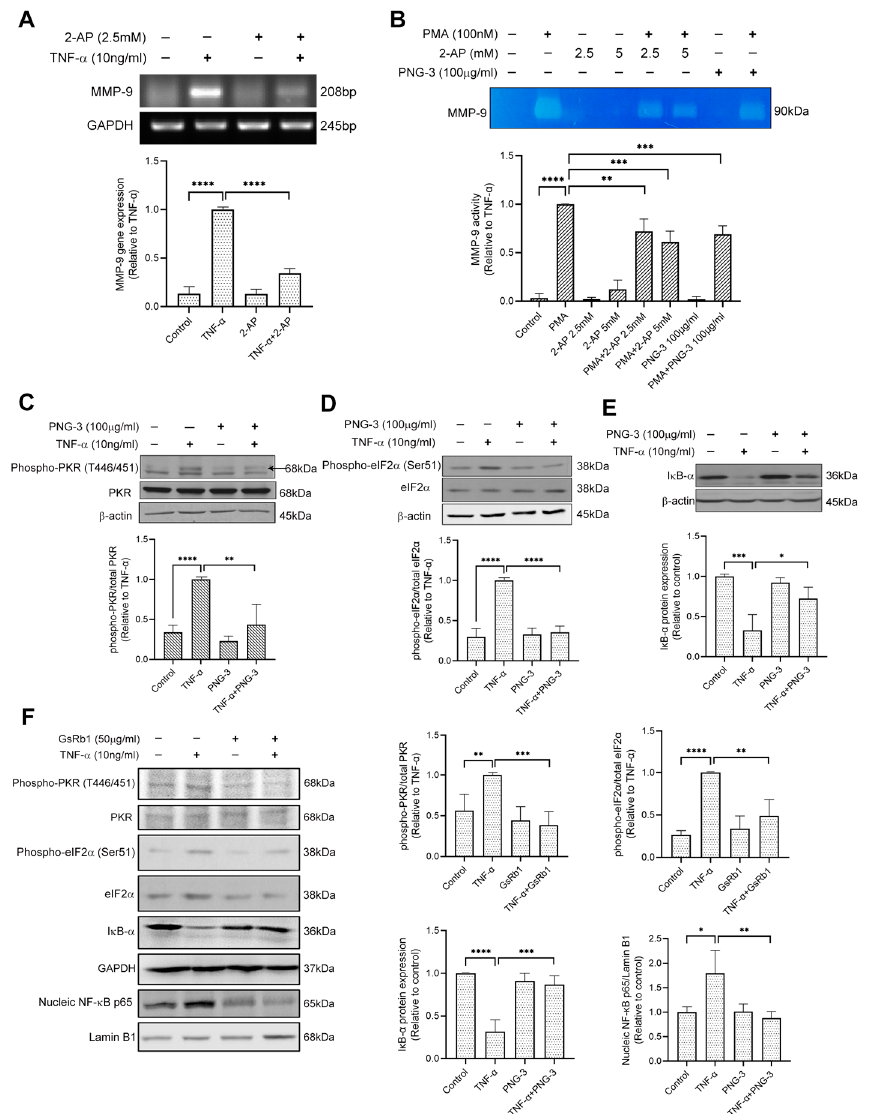
Figure 7. PNG-3 and Ginsenoside Rb1 (GsRb1) suppressed TNF- α /PMA-induced MMP-9 via PKR/NF- κ B in HepG-2 cells. ( A ) 2-AP suppressed TNF- α -induced MMP-9 gene expression in HepG-2 cell. ( B ) 2-AP and PNG-3 suppressed PMA-induced MMP-9 activity in HepG-2 cell. ( C – E ) PNG-3 extract suppressed TNF- α -induced phosphorylation of PKR and eIF-2 α and preserved the expression of I κ B. ( F ) GsRb1 suppressed TNF- α -induced phosphorylation of PKR, eIF-2 α and the nucleic expression NF- κ B p65, as well as preserved the expression of I κ B. Results are shown as mean ± SD, N = 4 in each group. * p < 0.05, ** p < 0.01, *** p < 0.001, **** p < 0.0001 vs. control or TNF- α only.